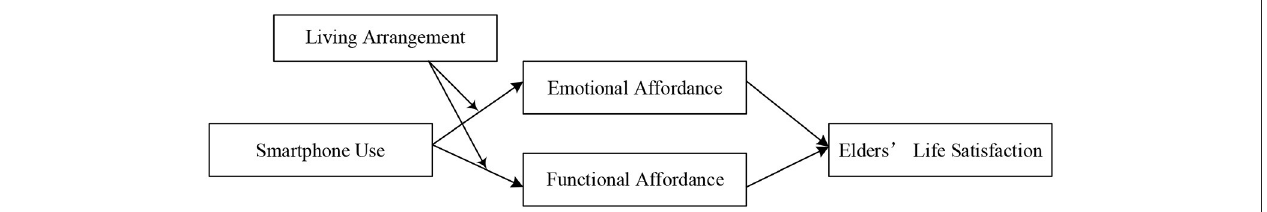
FIGURE 1 | Conception model.